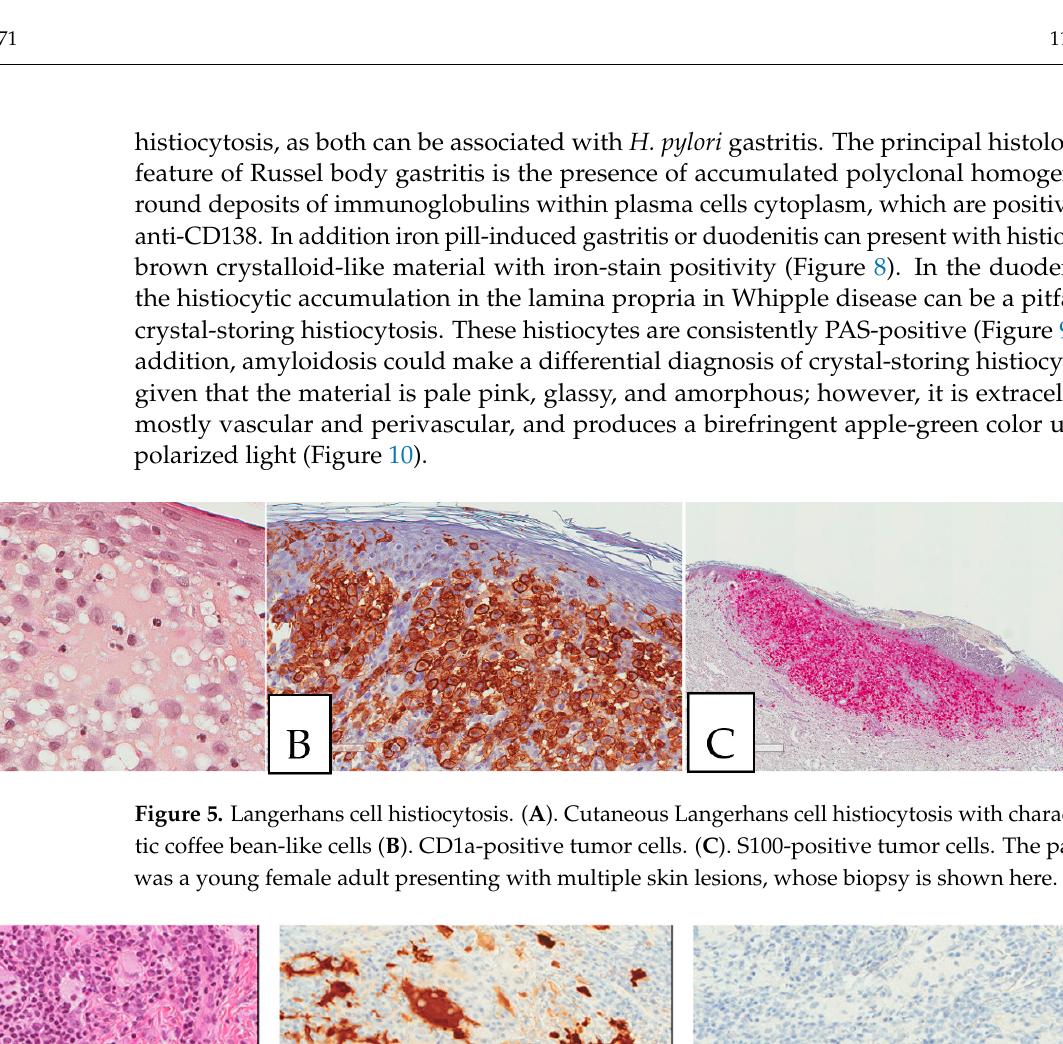
Figure 4. Rhabdomyoma cells also show an abundant eosinophilic cytoplasm. This lesion presented as a vocal cord polyp in a 67-year-old male patient.